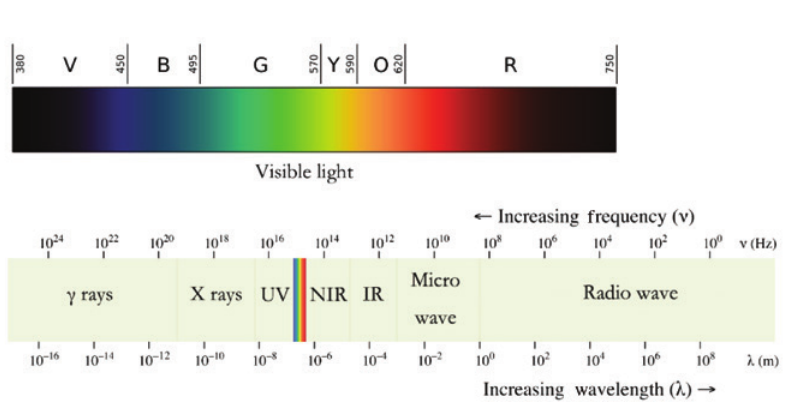
Figure 11: Wavelength and frequency of light [109].